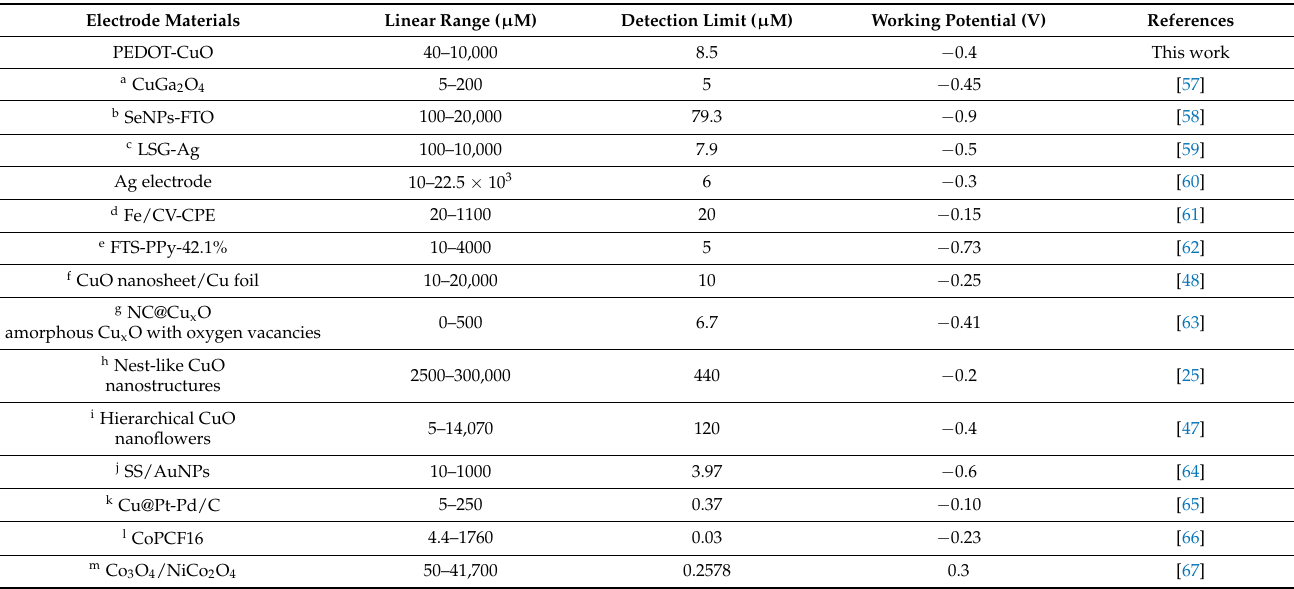
Table 1. The analytical performance comparison for previous hydrogen peroxide electrochemical sensors with the GCE/PEDOT-CuONPs